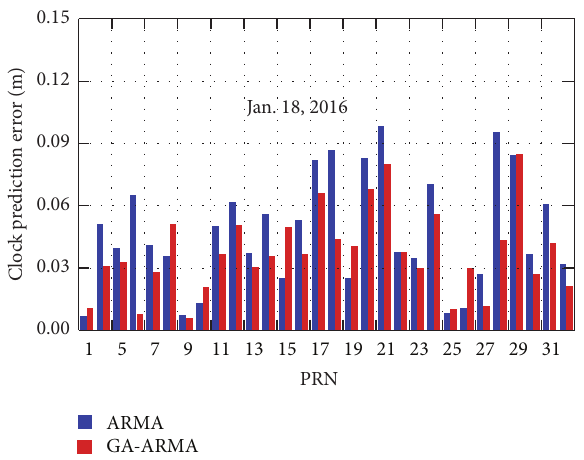
Figure 6: Clock prediction error for each satellite (January 18, 2016).